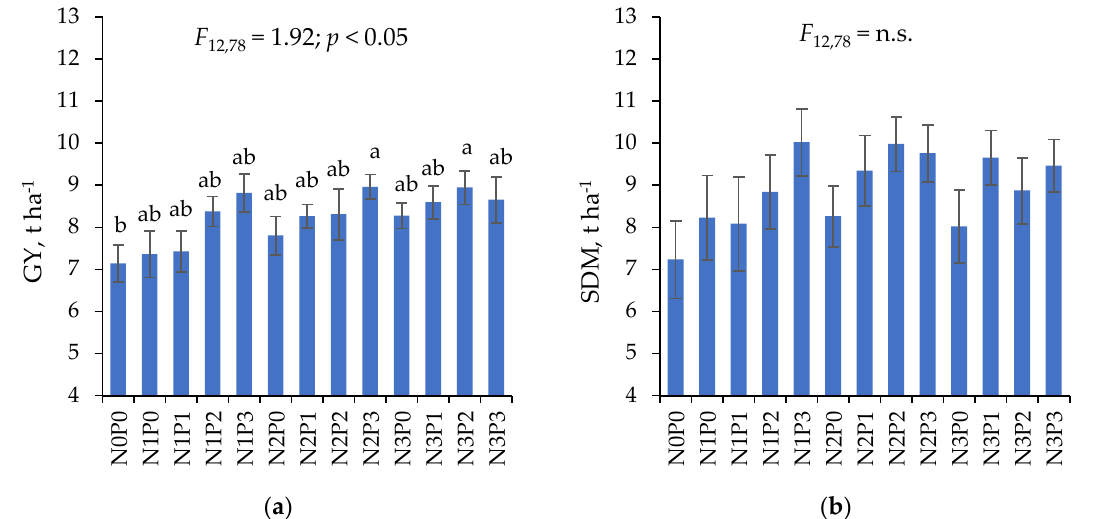
Figure 1. Maize grain yield, GY ( a ) and crop residues biomass, SDM ( b ) depending on fertilization treatments. Two-year average values. Means within a column followed by the same letter indicate a lack of significant difference between the fertilized treatments (HSD test). Hatched bars represent 2 × SEM ranges.